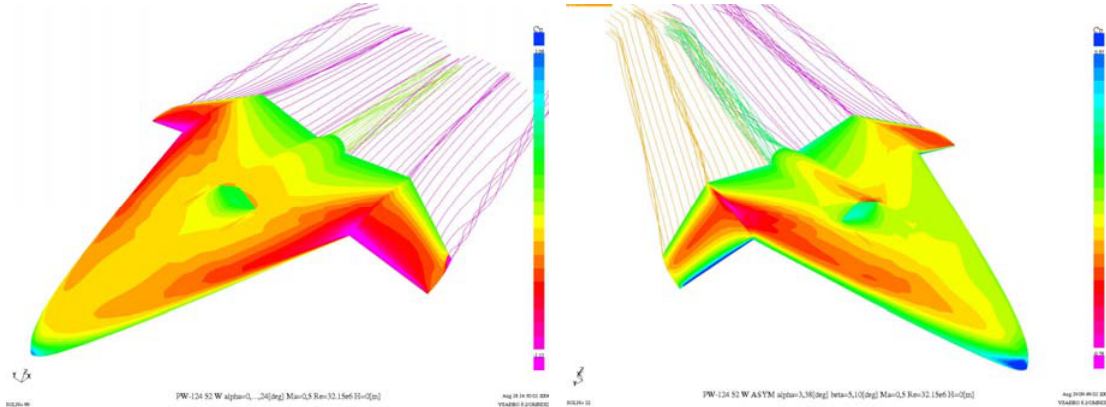
Fig 16. Cp distribution for PW-124HALE aircraft at a =3.38 o ,